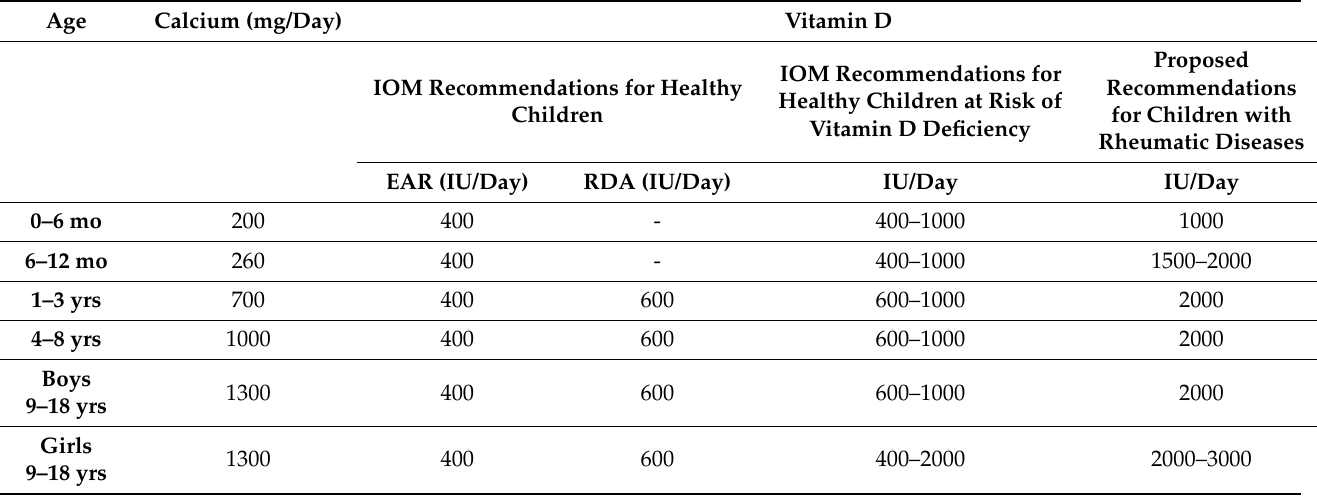
Table 3. Calcium and vitamin D recommended daily intake for healthy children and for children with rheumatic diseases (adapted from Vojinovic and Cimaz [160] and Galindo-Zavala et al.